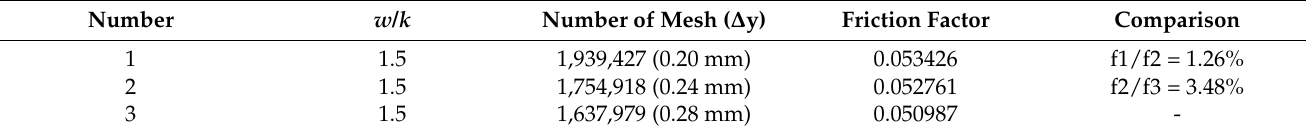
Figure 4. v -velocity distribution at the interface difference Δ y. Table 2. Grid independent test using friction factor.